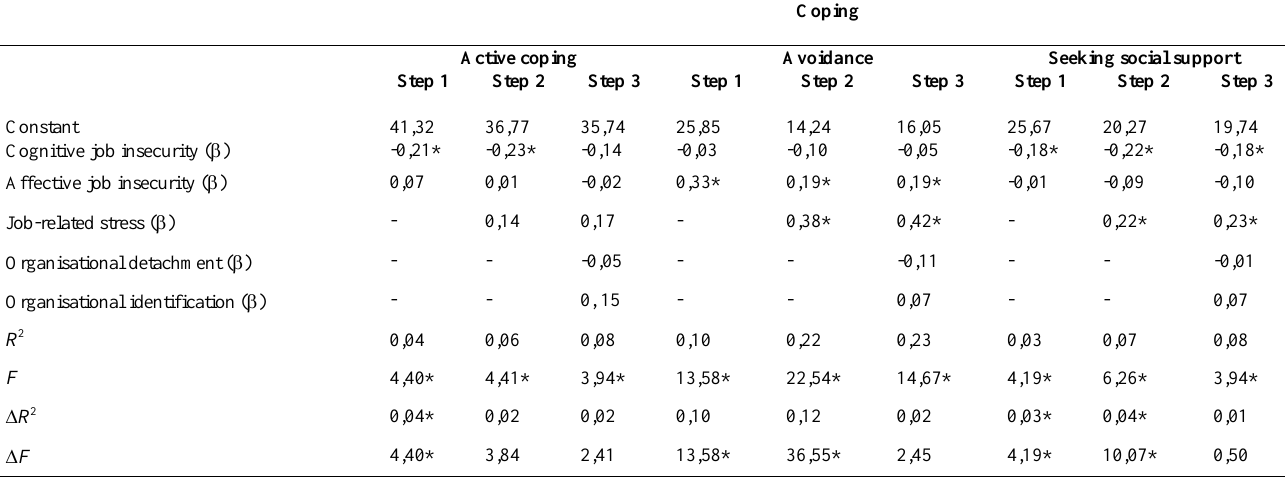
Table 4: Multiple regression analyses of job insecurity, organisational commitment and job-related stress on coping